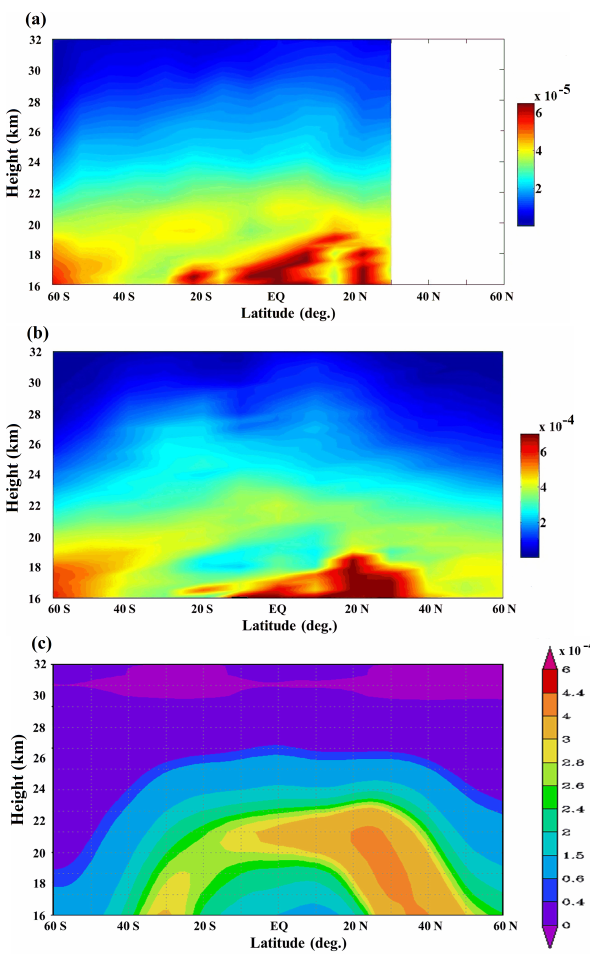
Fig. 6. “cross section” (averaged for June–September and 60– 120 ◦ E) of aerosol extinction (km − 1 ) as obtained from (a) HALOE 5.26µm for the year 2003 (b) SAGE II 0.525µm (c) ECHAM5- HAMMOZ simulations 0.550µm for the year 2003 at the altitude 16–32km.